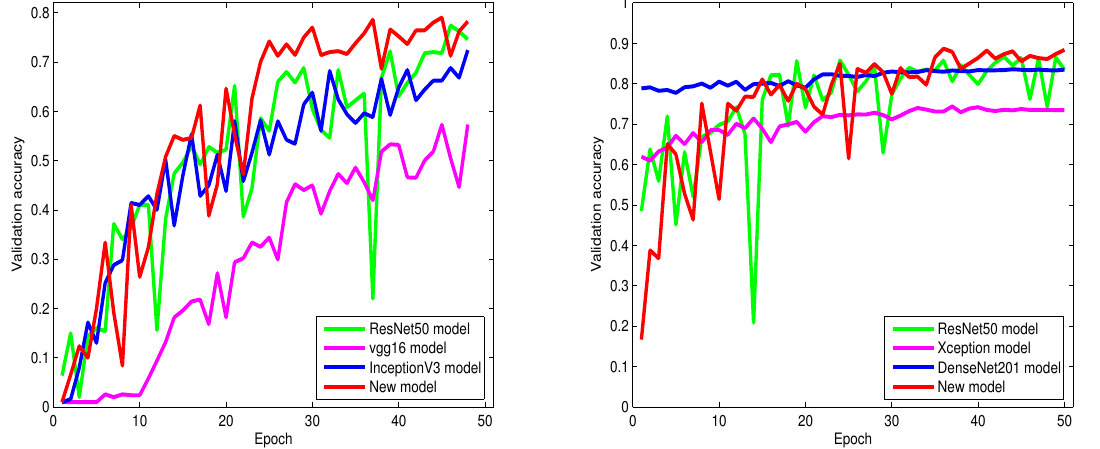
Figure 5. From left to right: the validation accuracy of the trained models on the 100 Sports Image Classification dataset and noisy (Gaussian noise) Intel Image Classification dataset.